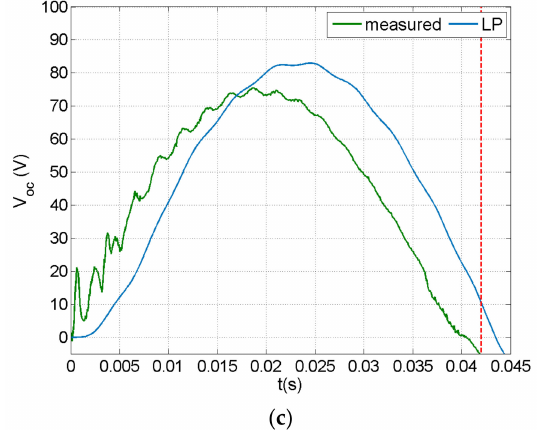
Figure 7. Time history of predicted and measured impact response (v i = 0.75 m/s) in open-circuit configuration: ( a ) impact force, ( b ) tip displacement and ( c ) electric potential at piezoelectric terminals.